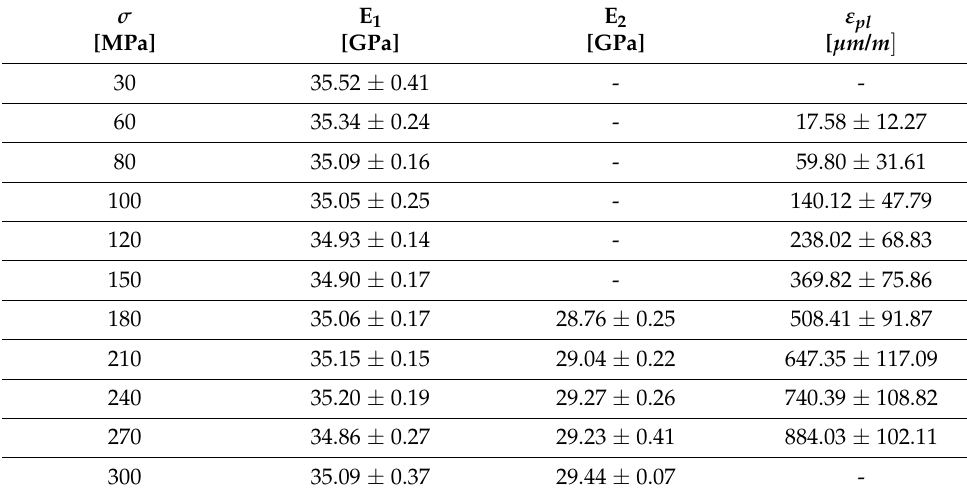
Table 4. Calculated E 1 , E 2 , and plastic strain for the repeated progressive load